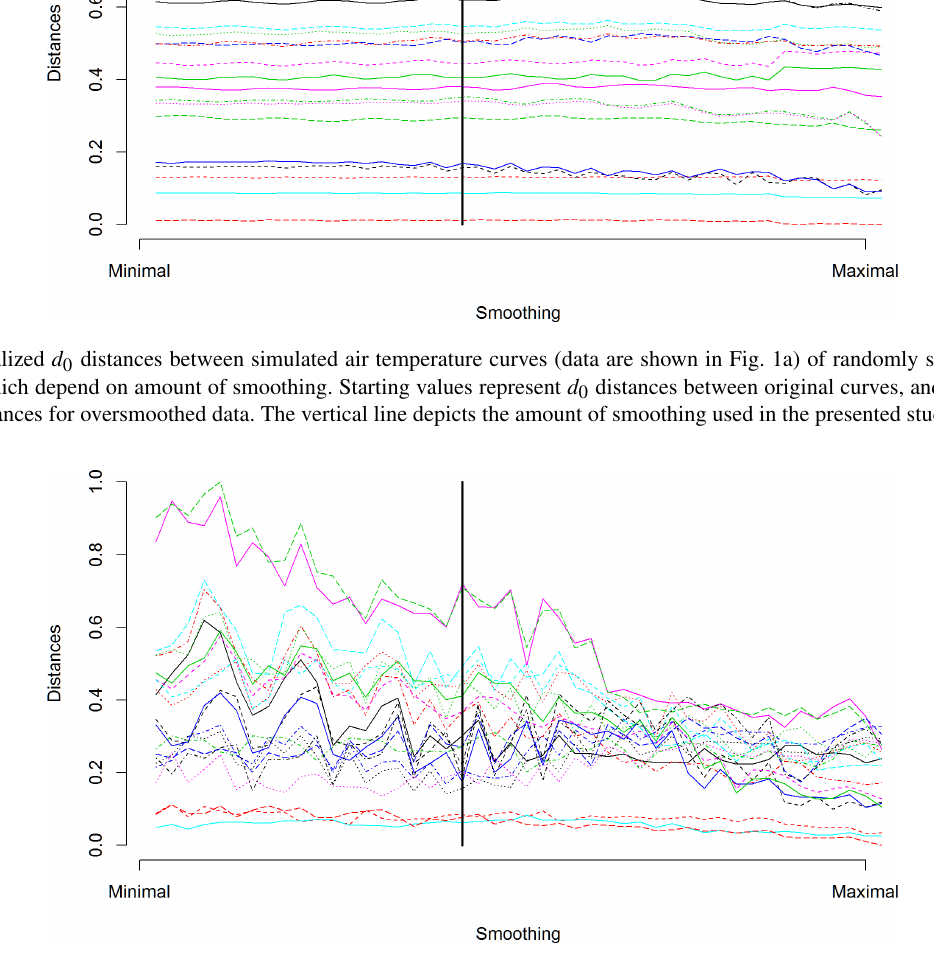
Figure 5. The same as Fig. 4, but for distances d 1